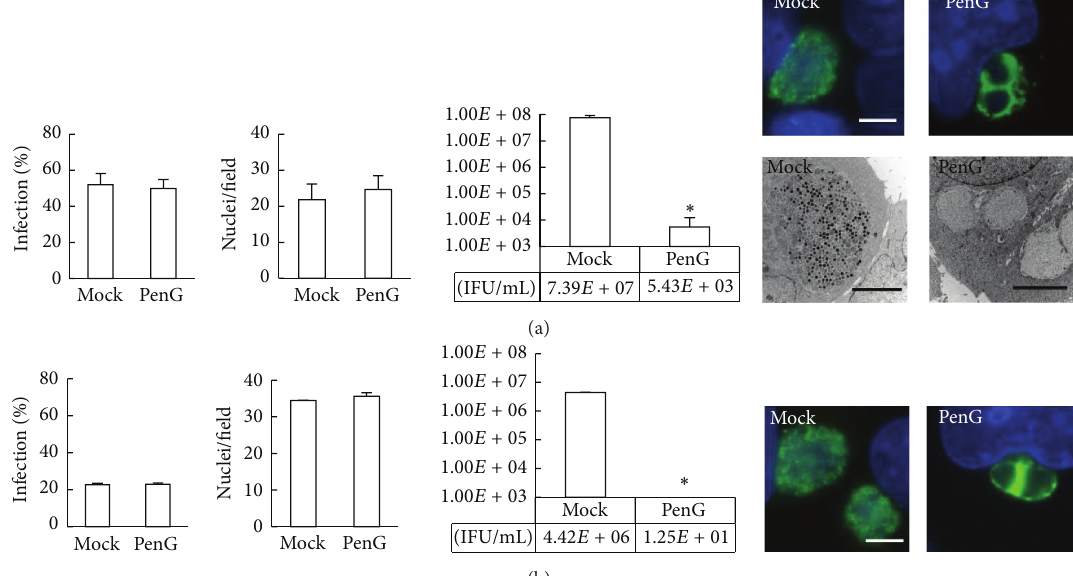
Figure 2: Penicillin G exposure induces aberrant body formation and reduces infectious elementary body production in Chlamydia pecorum . C. pecorum -infected HeLa cells were exposed to penicillin G (PenG), at 0 hours postinfection (hpi) until 35 hpi. Control infected cells were exposed to diluent only (mock). Cycloheximide was included (a) or not included (b) in the incubation medium. Inclusions were visualized using an antibody directed against chlamydial lipopolysaccharide (green), and DNA was labeled with 4 󸀠 ,6-diamidino-2 󸀠 -phenylindole dihydrochloride (blue). Percent of host cells infected and mean nuclei per field was determined by evaluation of 10 fields ( ≥ 200 cells), per coverslip, per sample. Representative immunofluorescence and transmission electron microscopic images illustrate normal inclusions in mock-exposed controls and inclusions containing aberrant bodies upon penicillin exposure. Infectious elementary body production was determined by titration by subpassage and expressed as inclusion-forming units (IFU)/mL. Results are means ± standard deviation. The two-tailed t -test was used to compare means; p ≤ 0.05 = significant ( ∗ ) ; 𝑛 = 3 (a) or 𝑛 = 2 (b). Scale bars = 5 𝜇